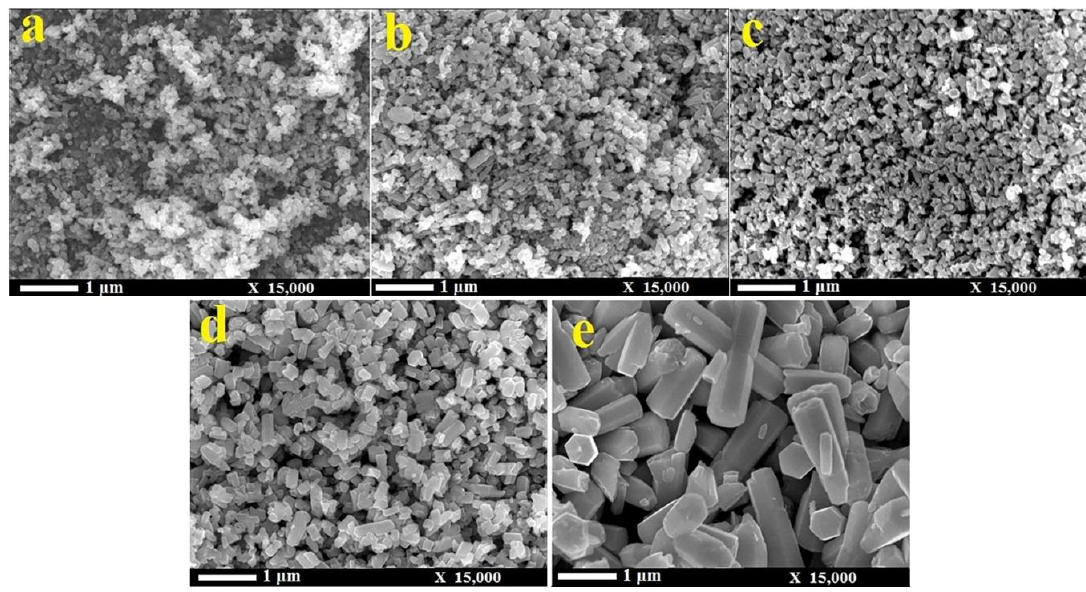
Figure 26. SEM images at the same magnifications of ZnO nanostructures produced with different molar ratios of Zn(NO 3 ) 2 · 6H 2 O and C 6 H 12 N 4 : ( a ) 3:20, ( b ) 5:20, ( c ) 12:20, ( d ) 20:20 and ( e ) 30:20.